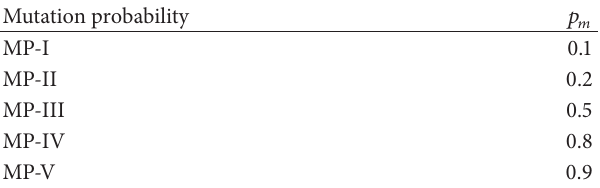
Table 7: Mutation probability.